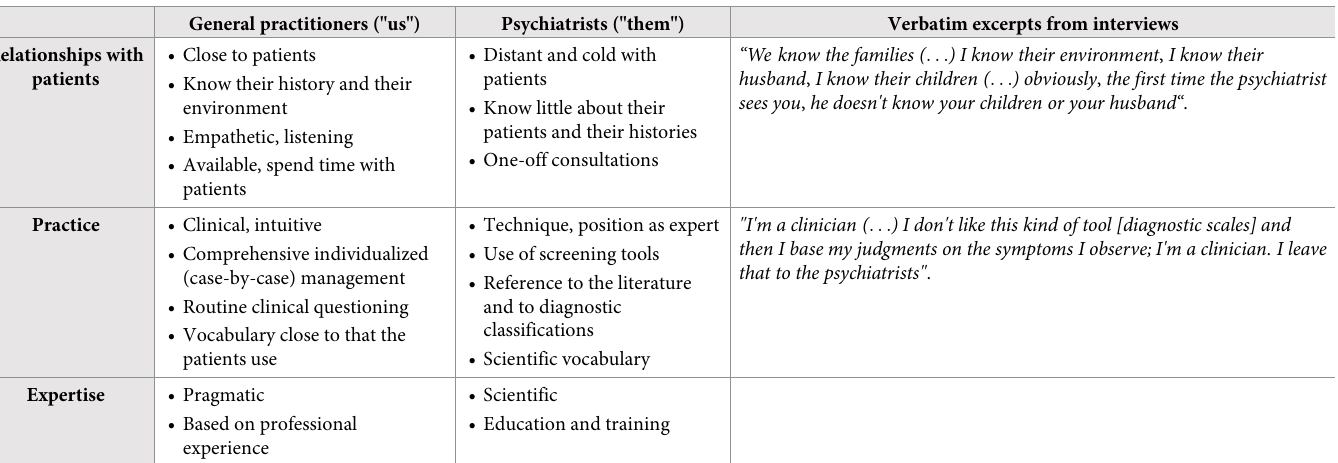
Table 5. Principal perceived differences between the practices of GPs and